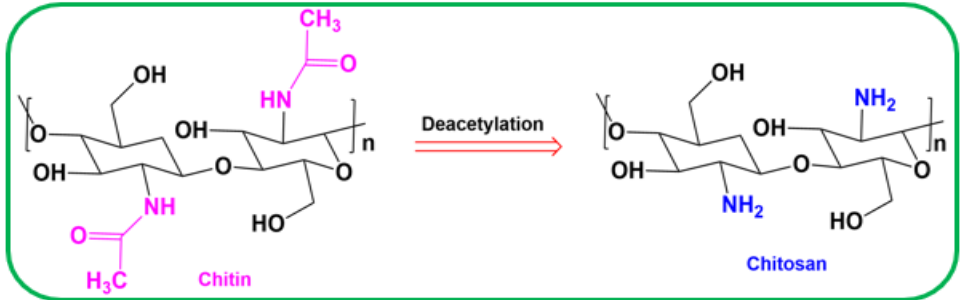
Figure 10. Deacetylation of chitin into chitosan and the associated chemical structures.